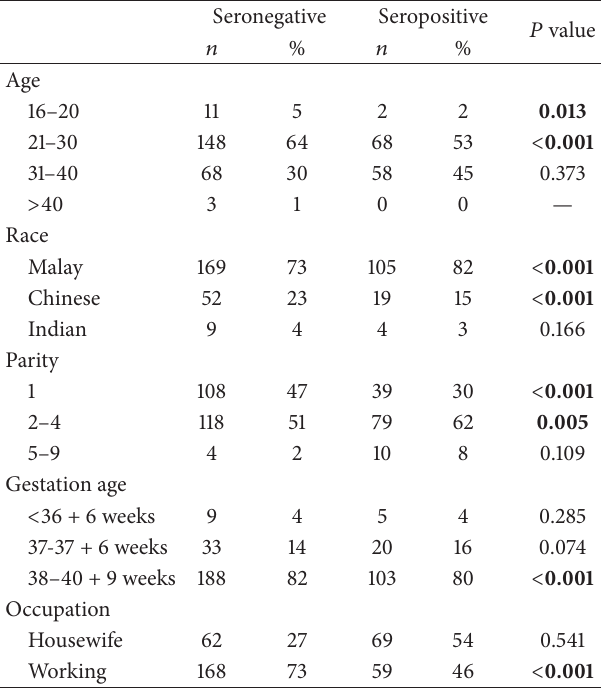
Table 2: Seroprevalence versus maternal